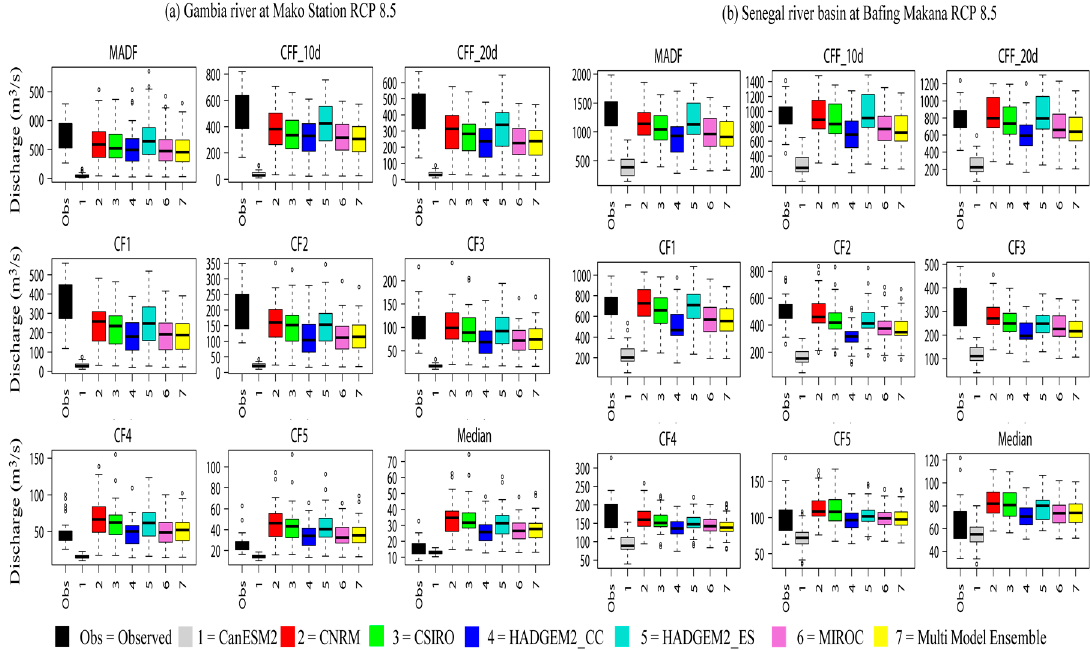
Figure 7. Evolution of characteristic flow rates by 2050 under the RCP8.5 scenario.